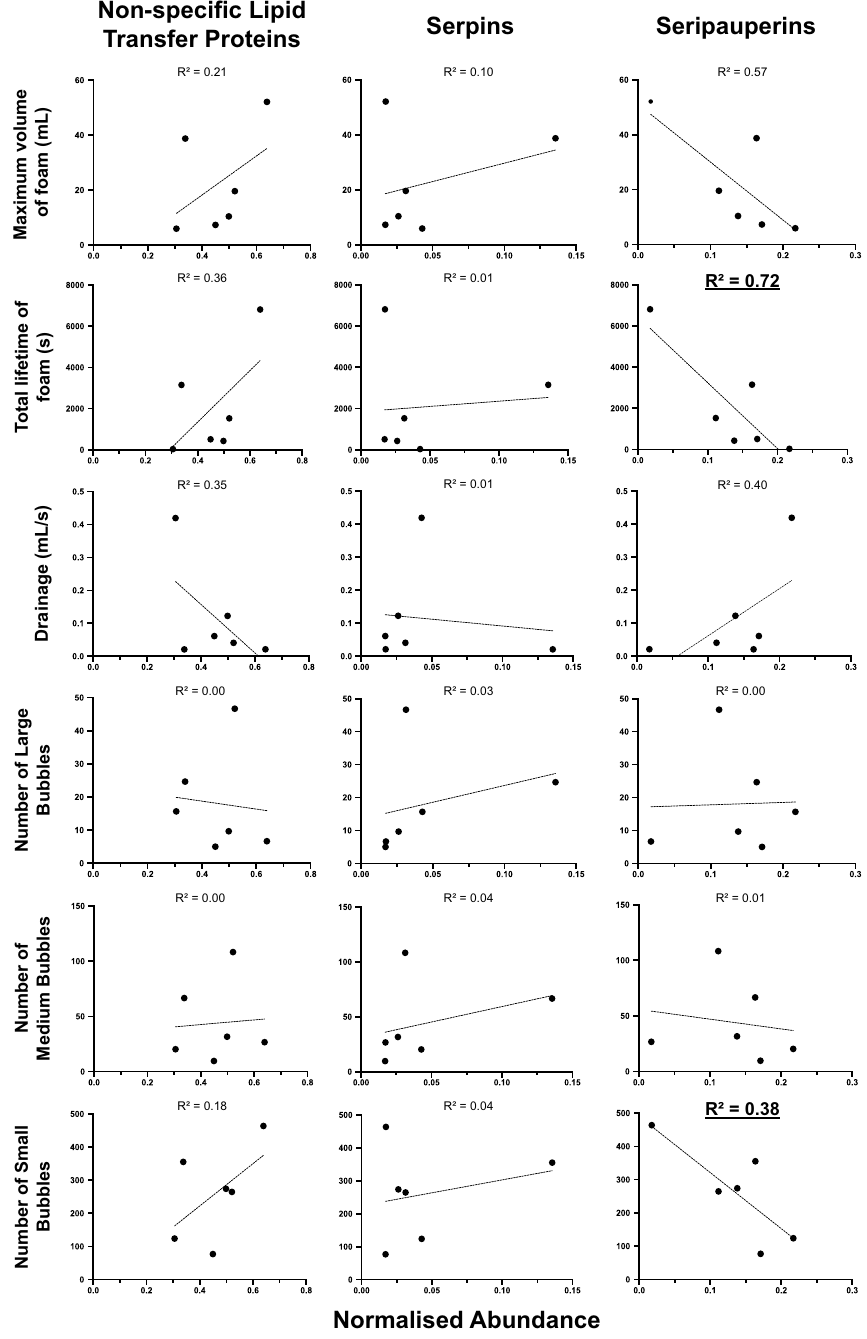
Figure 5. Linear regression analysis of barley and yeast glycoprotein abundance and beer foam characteristics. Correlations of summed normalised abundance of Non-specific Lipid Transfer Proteins (NLTPs), Serpins, and Seripauperins with: maximum volume of foam; total lifetime of foam; foam drainage; and number of large, medium, small bubbles. Values, mean. Line, linear regression with coefficient of determination, R 2 . Bold and underlined, significant ( p <